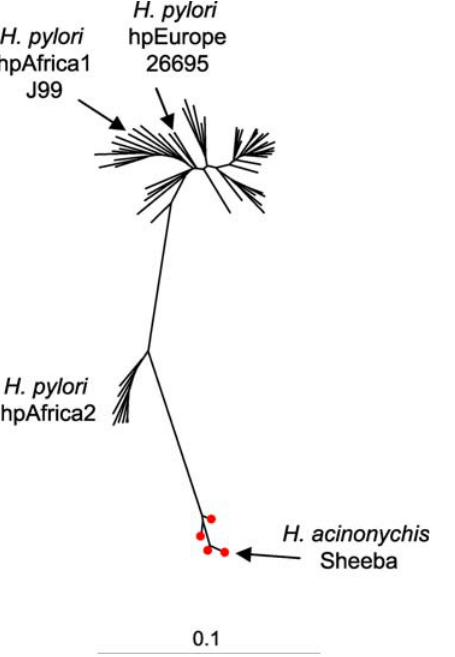
Figure 1. Neighbor-Joining Tree Based on the GTR þ G þ I Evolutionary Model for 3,406 bp Sequences from 58 Strains of H. pylori and Four Strains of H.